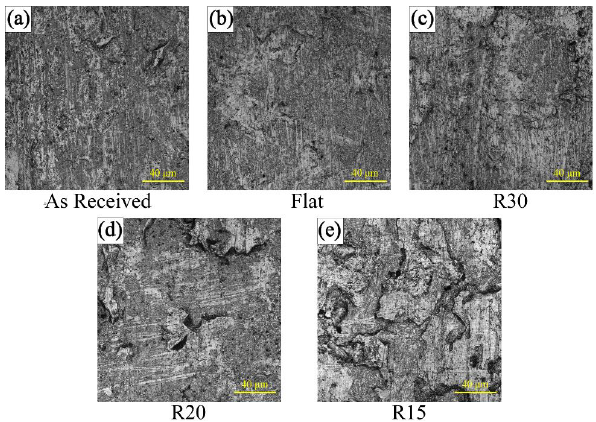
Figure 20. Surface roughness of the specimens stamped by flat and curved dies (R30, R20, R15).